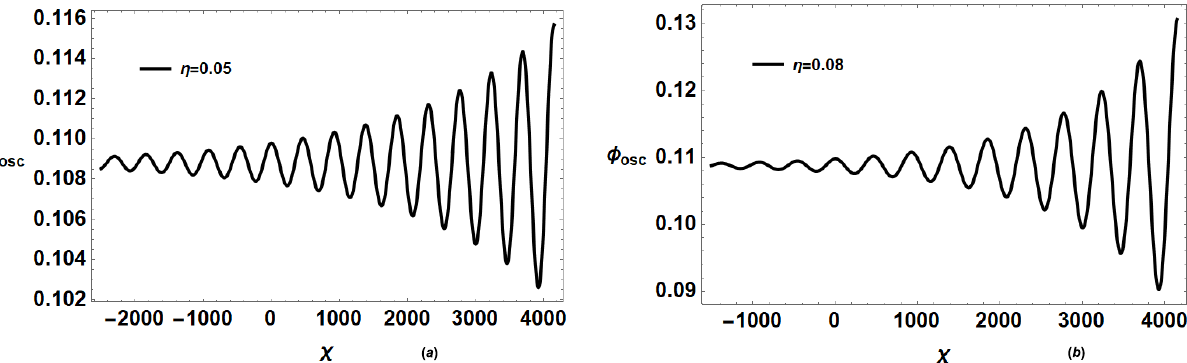
Figure 5. (Color online) Variation of oscillatory shock waves for different values of viscosity ( η ) ( a ) η = 0.05 ( b ) η = 0.08, with fixed values of l z = 0.6, µ b = 0.2, V b 0 = 0.4, γ b = 0.5, H = 0.2 and T = 0.2.